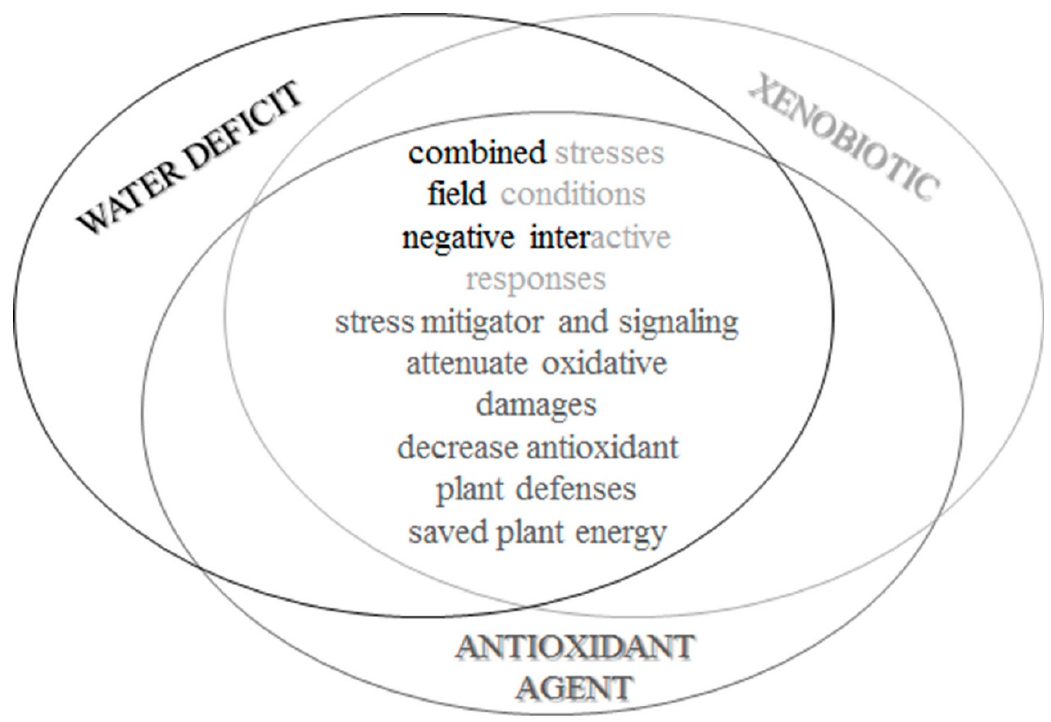
Figure 9. Conclusion figure about results found in this article, showing the interactions of the combination of water deficit and xenobiotic stress and the antioxidant agent mitigating in soybean